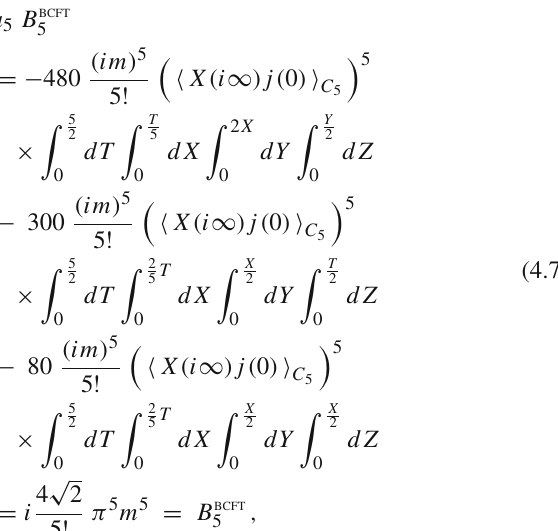
The a 5 coefficient is easily